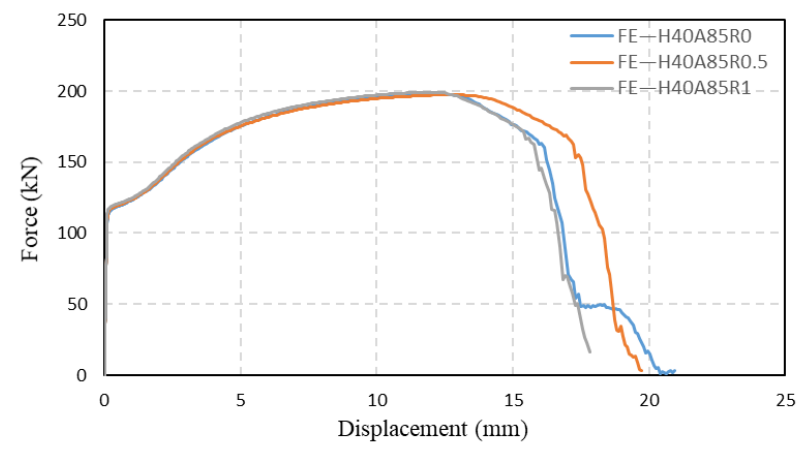
Figure 18. E ff ect of chamfering radius on load–displacement curves. Appl. Sci. 2020 , 10 , x FOR PEER REVIEW Figure 18. Effect of chamfering radius on load–displacement curves.